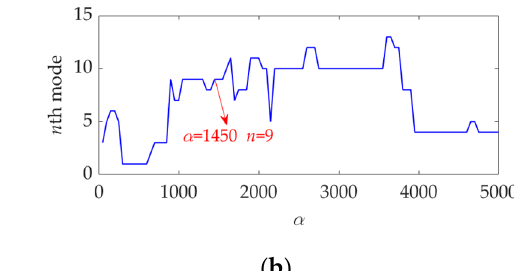
Figure 12. Relationship between the α value and ( a ) the EP index value and ( b ) order number of the target mode at each step of α increase.